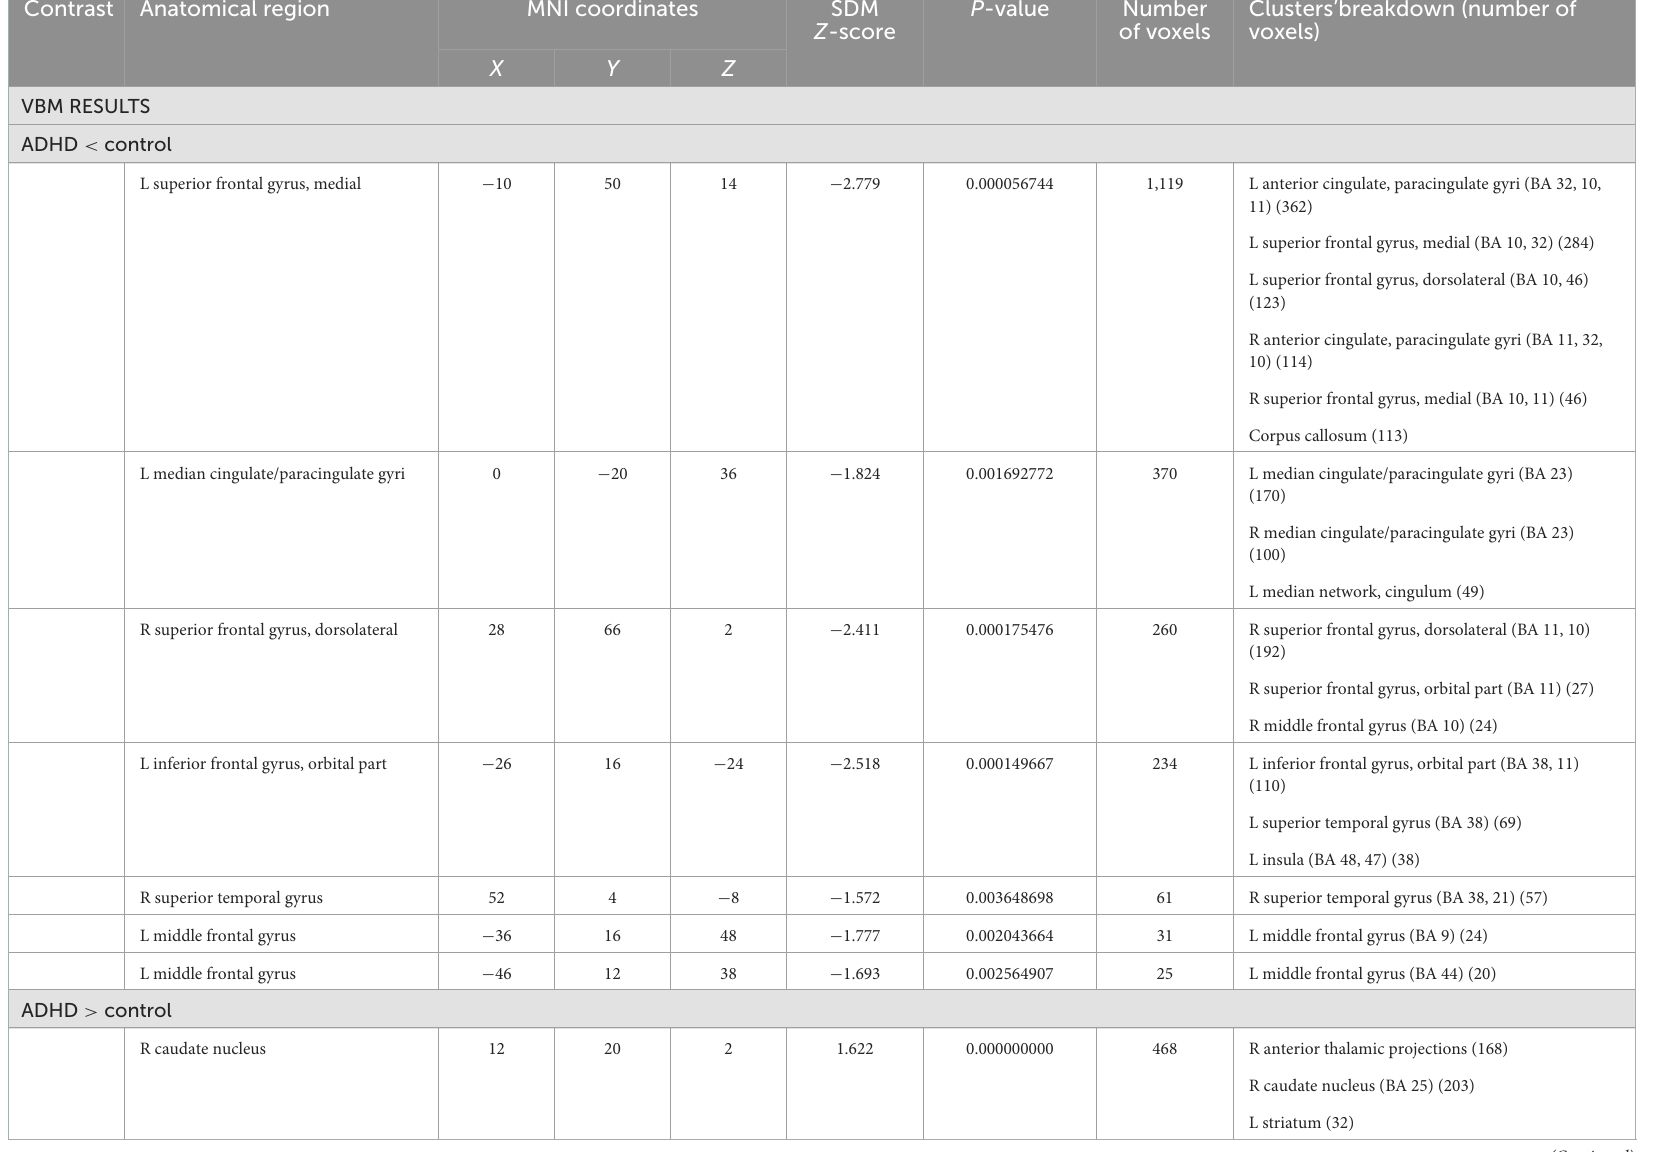
P -value Number Clusters’breakdown (number of Z -score of voxels